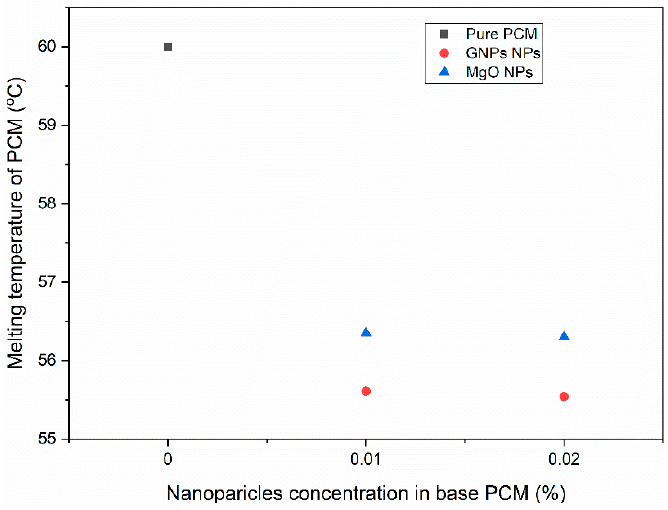
Figure 10. Melting temperature of PCM, GNPs/PCM based and MgO/PCM.